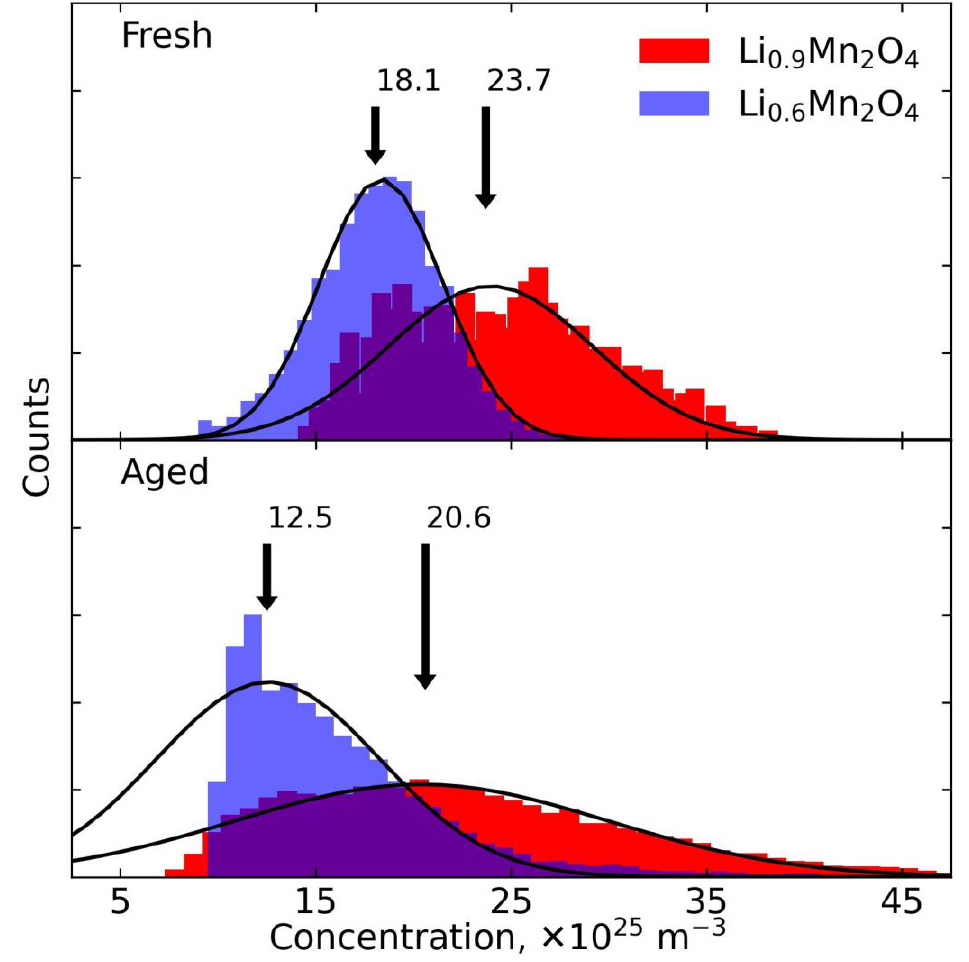
Figure 3. Histograms of lithium ion concentration in fresh and aged LMO cathodes extracted from ESM images. Black arrows indicate average concentrations.